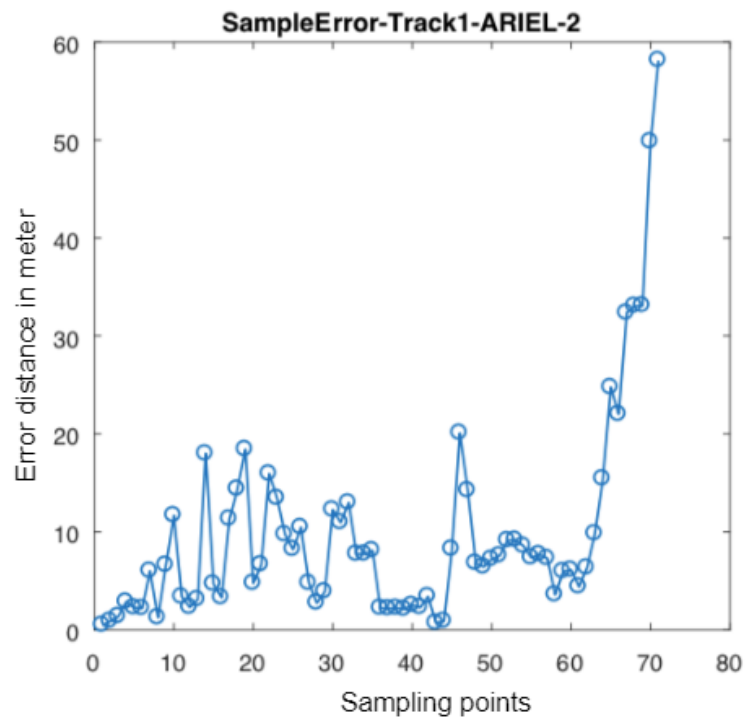
Figure 6. Error estimation of each of 70 points along the evaluation process. A travelator (moving walkway) in the evaluation path probably generated the large reported error from significant compass drift in the last few